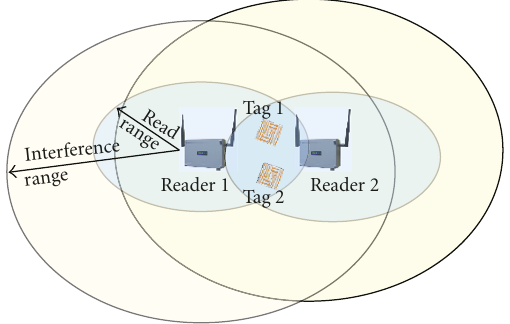
Figure 2: Reader-Reader Collision Problem: tags fall within the read range of multiple readers (called overlapped tags), and the query-response sequence with one reader is interfered with by the simultaneous query-response sequence with other readers. In this example, Tag 1 and Tag 2 are overlapped tags within the read range of both Reader’s 1 and 2. When both readers operate at the same time, each interferes with the query-response sequence of the other with any of the overlapped tags. This type of interference is stronger (as compared to that of Figure 1) as the a ff ected tag is also within the read range of the interfering reader and a ff ects both the reception as well as response of signals to/from the